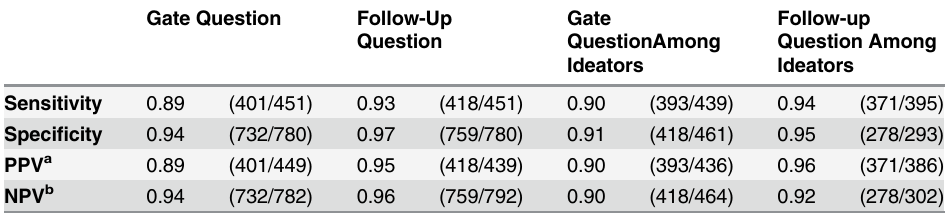
Table 4. Classification statistics for the suicide attempt gate and follow-up